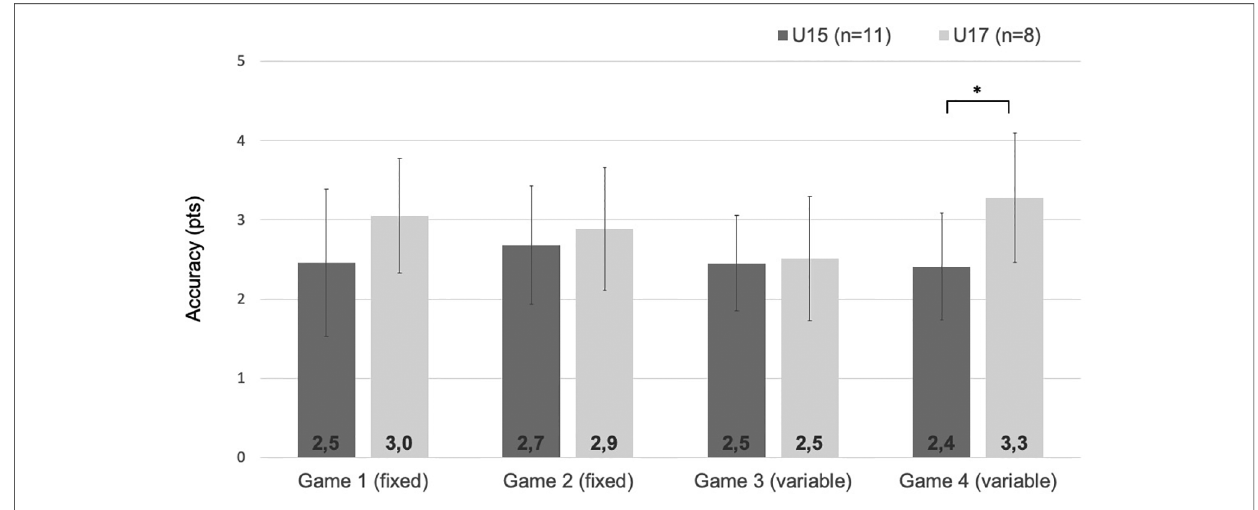
FIGURE 2 Accuracy in fi xed and variable games for players U15 and U17. This fi gure shows the mean accuracy in various game situations (errors bars represent standard deviations of the mean); * p <0.05 signi fi cant difference between players U15 and U17 for